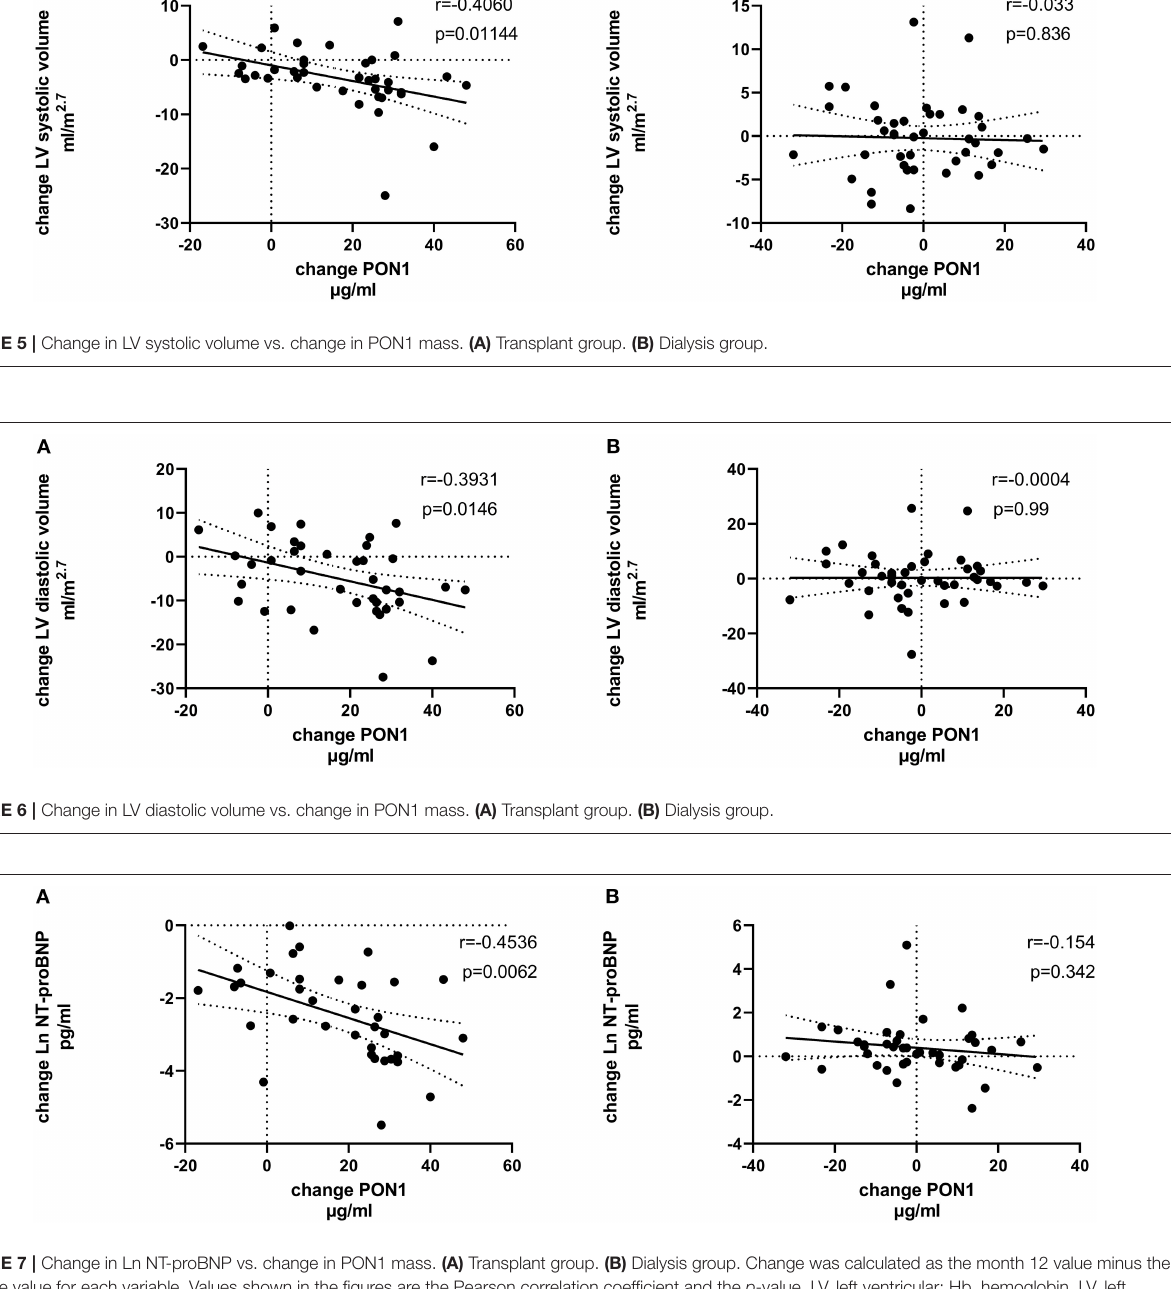
cholesterol, does not uniquely share a common factor with change in hemoglobin or LV